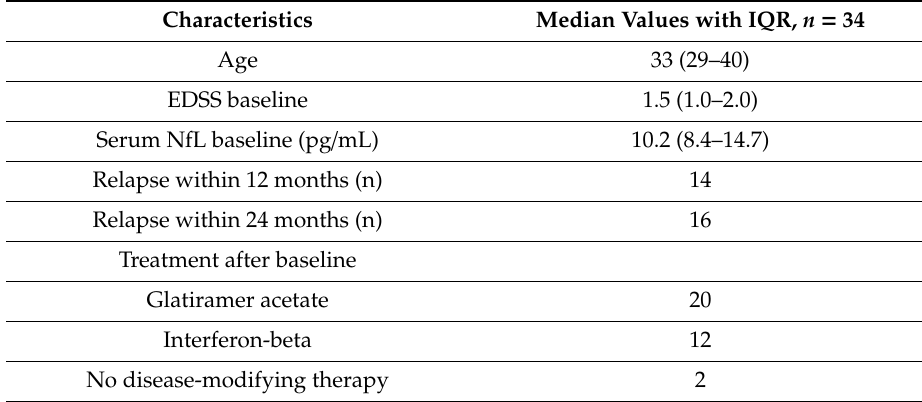
Table 1. Patients’ characteristics.